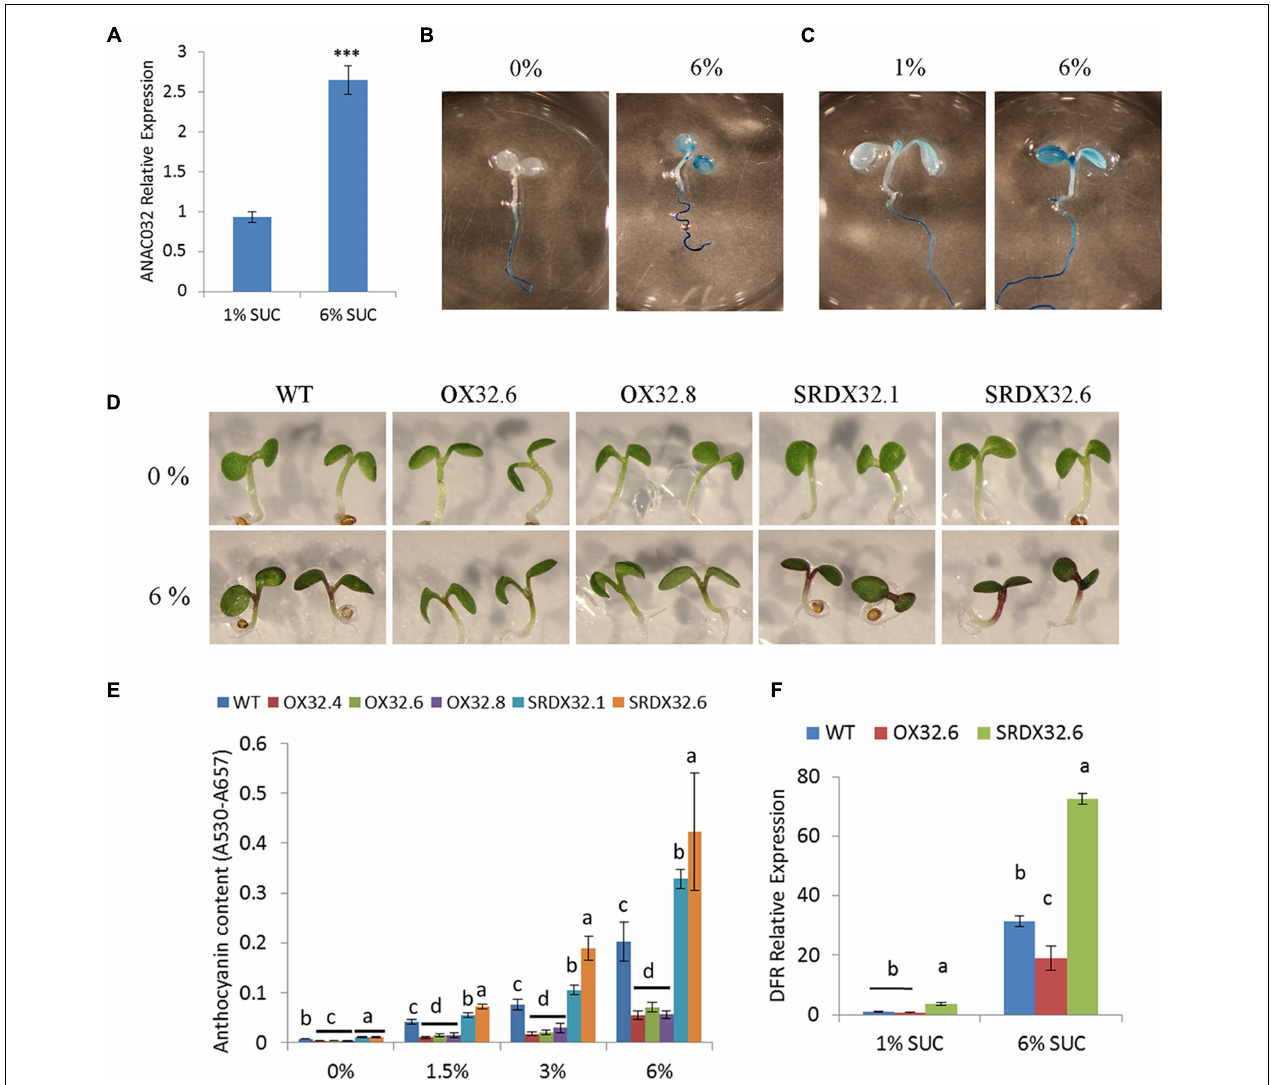
FIGURE 1 | Regulation of sucrose–induced anthocyanin by ANAC032 in Arabidopsis . (A) qRT-PCR analysis of ANAC032 expression in response to sucrose treatment. Five-day-old seedlings were transferred to fresh half-strength MS plates supplemented with 1% or 6% sucrose for 24 h under continuous light conditions. Data represent mean values ( ± SD). UBC21 was used as internal control. Data were analyzed using Student’s t -test ( ∗∗∗ P < 0.01). (B,C) β -glucuronidase activity of P ANAC032 : GUS line in response to high sucrose treatment. Five-day-old seedlings of P ANAC032 : GUS line, grown on half-strength MS plates with 0% (B) and 1% (C) sucrose were transferred to MS plates supplemented with 6% sucrose for 24 h, followed by incubation in GUS-staining solution overnight in dark at 37 ◦ C. (D) Phenotypic response of wild-type (WT) and ANAC032 transgenic lines (OX32; overexpressors and SRDX32; chimeric repressors) after 5 days of growth on half-strength agar plates containing 0 and 6% sucrose. (E) Anthocyanin content in the seedlings of ANAC032 transgenic lines, grown on half-strength MS agar plates containing 0, 1.5, 3, and 6% sucrose, after 5 days of growth. Data represent mean values ( ± SD; n = 3). (F) qRT-PCR analysis of DFR (dihydroflavanol reductase) expression in response to high sucrose treatment. Five-day-old seedlings of WT and ANAC032 transgenic lines were transferred to fresh half strength MS plates containing 1 and 6% sucrose for 24 h. UBC21 was used as internal control. Within each treatment, bars with different letters in (E,F) are statistically not similar to each other according to one way ANOVA LSD test ( P <